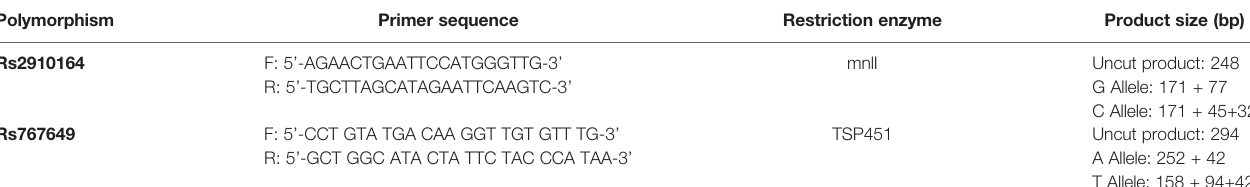
TABLE 2 | PCR primer sequences used and expected fragment